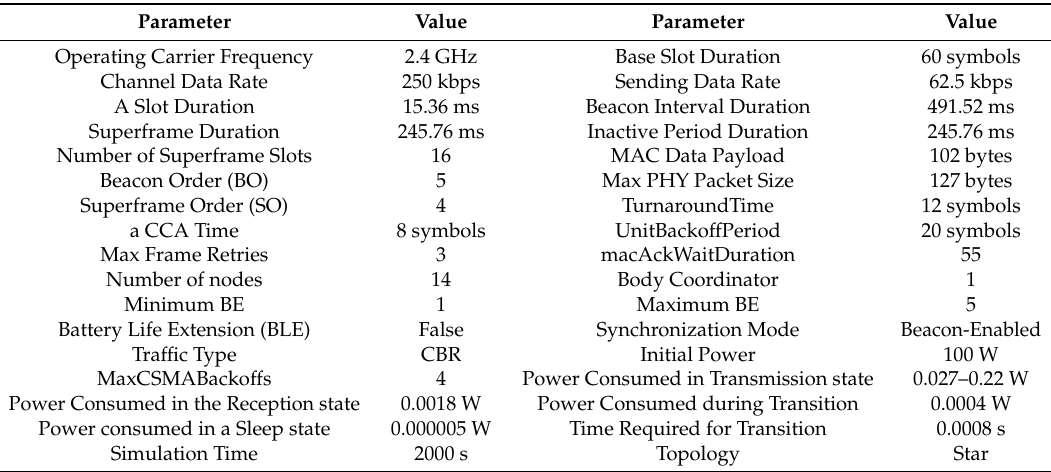
Table 3. Simulation